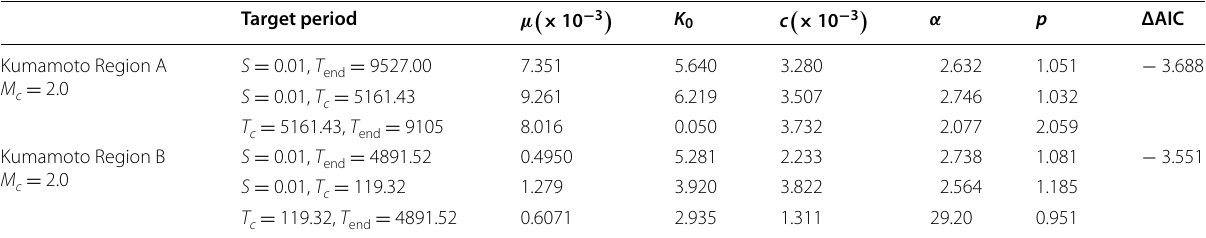
The datasets start at 00:00 on January 1, 1990, and at 10:53 on June 8, 2000 (the occurrence time of a M5.0 event), for Regions A and B, respectively. For each region, the first row shows the MLE estimates of the parameters for the entire period ( S, T end ) with the associated baseline AIC until the change-point ( S , T c ) is associated with AIC AIC 1 , and the third row for the target period after the change-point ( T c , T end ) is associated with AIC = last column shows ΔAIC AIC 1 AIC 2 AIC 0 = + − Table 6 MLEs of the single and two-stage ETAS models for the foreshock sequence Target